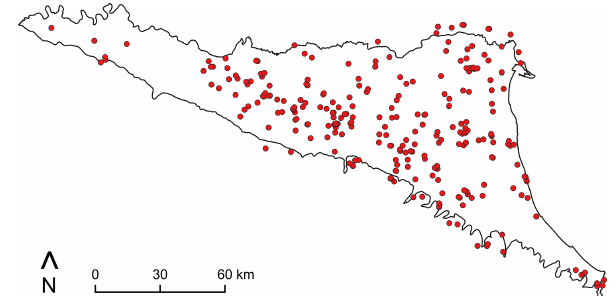
Figure 4. Spatial distribution of 338 isolated outliers within the study area.